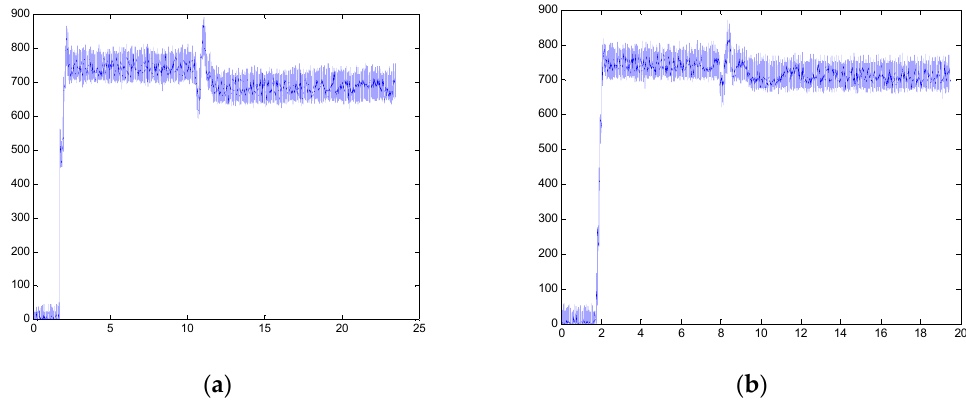
Figure 8. Configuration of the load disturbance. ( a ) The traditional SMC; ( b ) the proposed SMC.